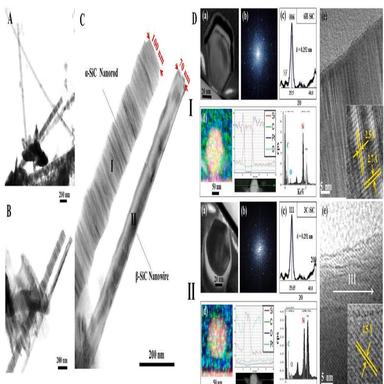
Transmission Electron Microscopy (TEM) micrographs indicating the respective compositional properties and crystal structure of the 1D-SiC Nanostructures prepared at 1550 ◦C. A) Bright-field TEM of the distinctive morphologies. B) Comparison between SiC Nanowire (I) and Nanorod (II). C) Dimensional characteristics of the upper section and apex of Nanostructures I and II. D) (a) FIB/SEM indicating cross-sectional plane with distinctive hexagonal geometries. (b) Fast Fourier Transformed (FFT) pattern. (c) XRD